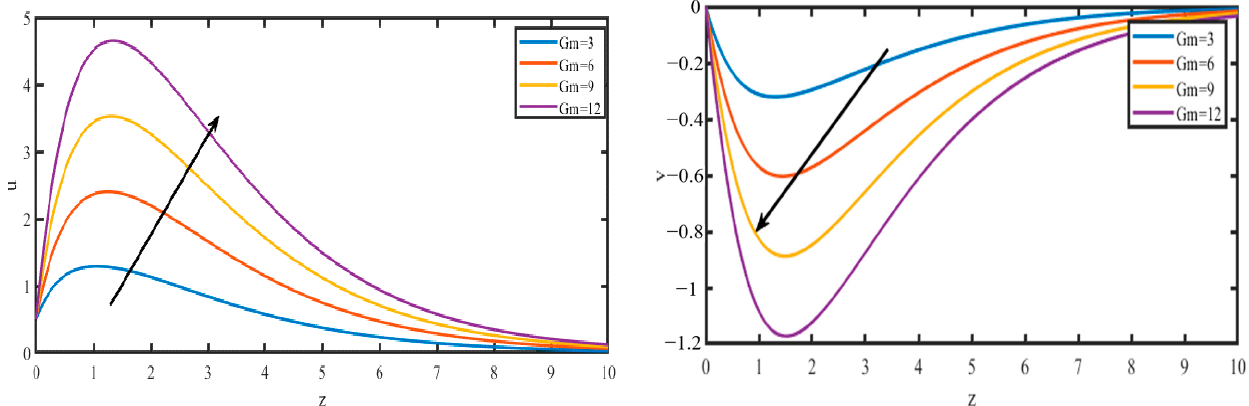
Figure 3. The velocity patterns for u and v plotted vs. Gr, with k = 0.50, R = 1.0, M = 2.0, S = 1.0, Gm = 3.0, m = 0.20, Pr = 0.710, H = 1.0, Sc = 0.220, Kc = 1.0, n = 0.50, t = 0.50, So = 0.50, F = 1.0.